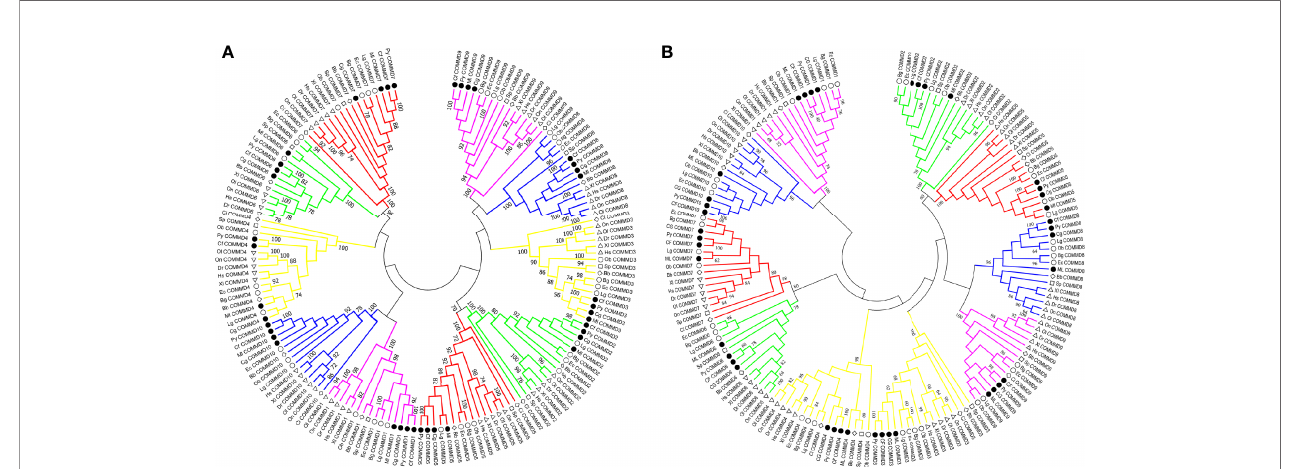
FIGURE 4 | Phylogenetic analyses of COMMD gene families involving 154 amino acid sequences across 16 animals were conducted based on the NJ method and ML method. (A) Phylogenetic analysis of COMMD proteins using the NJ method, with a bootstrap of 1,000 replicates. (B) Phylogenetic analysis of COMMD proteins using the ML method, with a bootstrap of 1,000 replicates. Numbers in the trees represent the con fi dence interval. Different symbols were used to represent different clades of animals: the circles label the molluscs, the diamonds label the chordates, the triangles label the vertebrates, and the squares label the cnidarians. Four bivalve COMMDs were specially emphasized by solid color inside the symbol. Hs, Homo sapiens ; Xl, X enopus laevis ; Dr, Danio rerio ; Ol, Oryzias latipes ; On, Oreochromis niloticus ; Ci, Ciona intestinalis ; Bb, Branchiostoma belcheri ; Sp, Stylophora pistillata ; Py, Patinopecten yessoensis ; Cf, Chlamys farreri ; Cg, Crassostrea